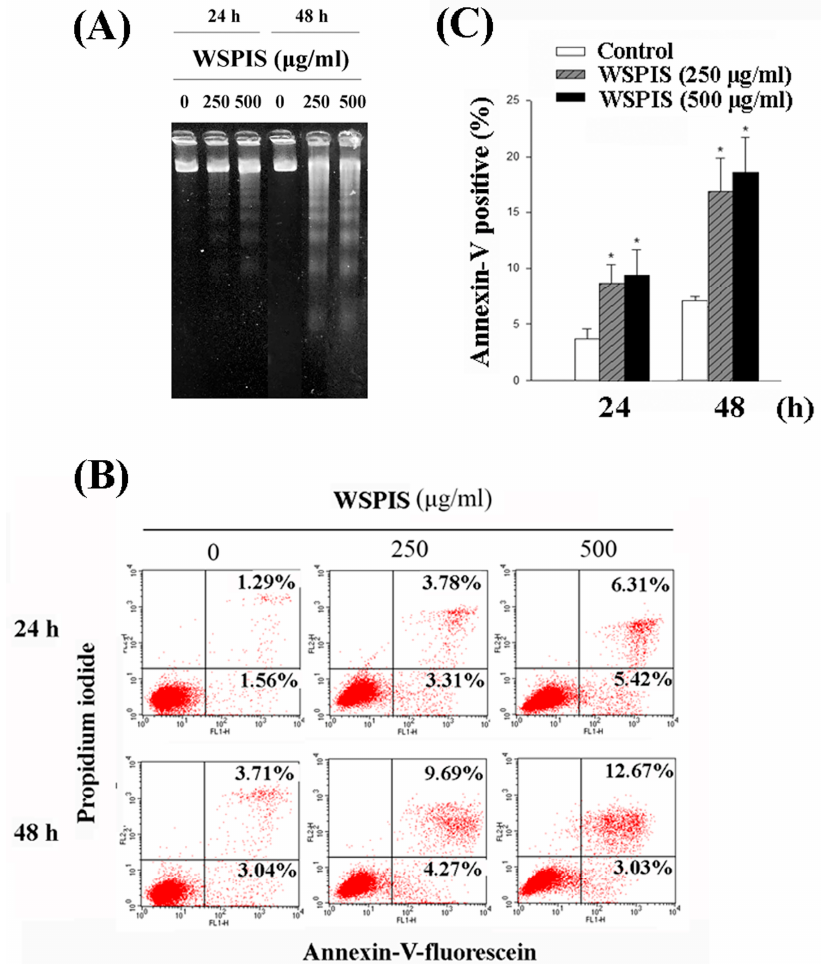
Figure 3. Apoptotic effects of WSPIS in THP-1 cells. Cells were treated with various concentrations of WSPIS (250 and 500 µ g/mL) for 24 and 48 h. ( A ) DNA fragmentation was analyzed by agarose gel electrophoresis. Data are representative of three independent experiments. ( B ) Annexin-V-positive cells were analyzed by flow cytometry after annexin-V/propidium iodide staining. ( C ) Apoptotic cells (annexin-V-positive) are expressed as mean ± SD of three independent experiments. * denotes the data that are significantly different from control at p < 0.05.